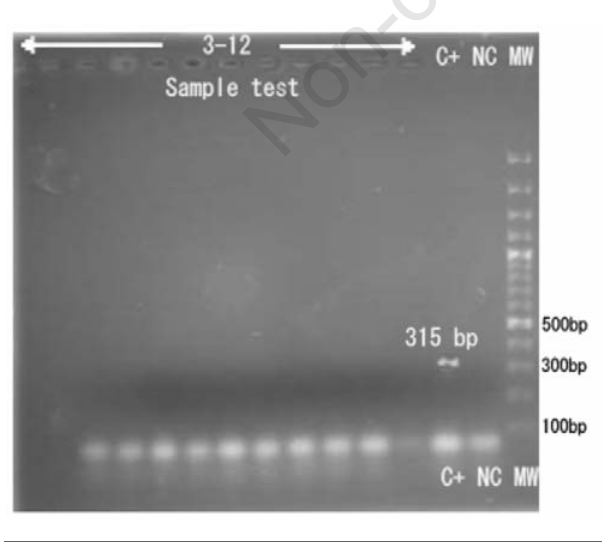
Figure 2. Image of the ethidium bromide stained gel of the 1492 bp omp1 gene band in urine polymerase chain reaction